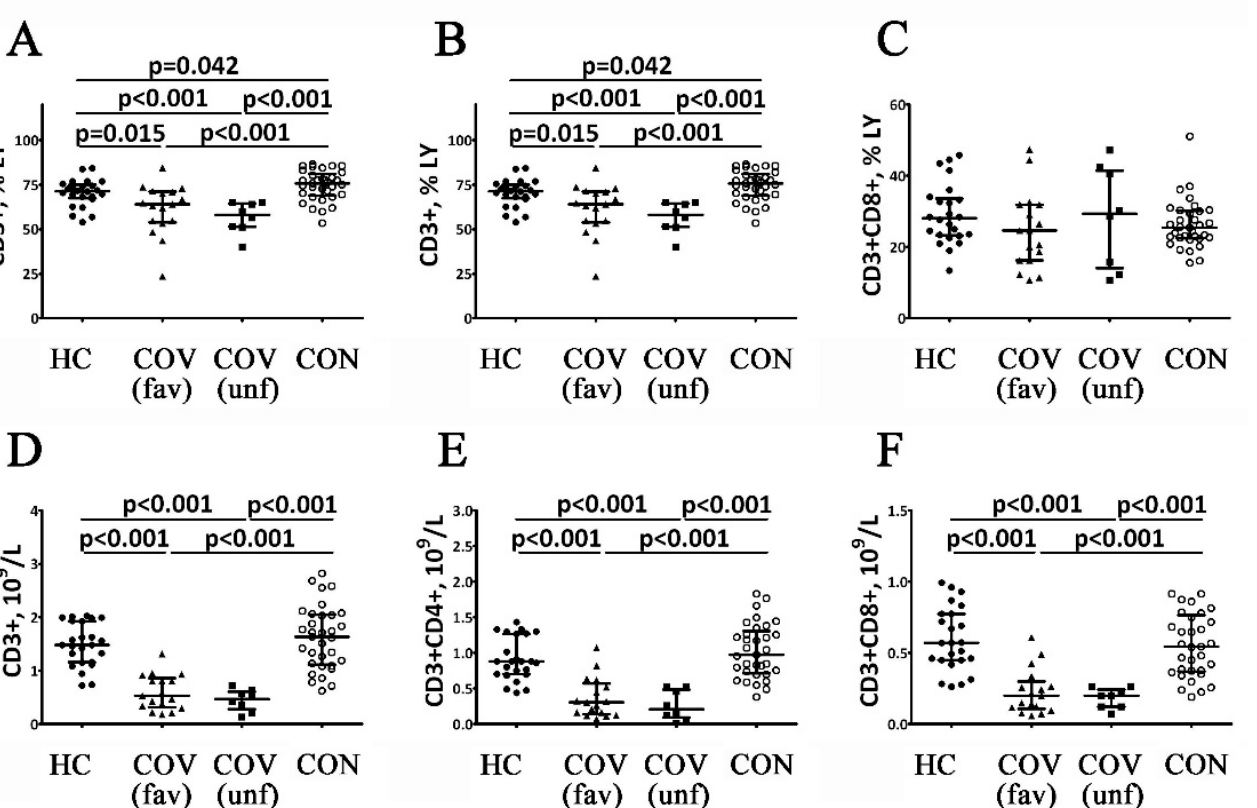
Figure 2. Altered relative and absolute numbers of main T cell subsets in patients with acute COVID- 19 and COVID-19 convalescent patients. Scatters plots ( A – C ) and ( D – F ) showing the percentages (the percentage of T cell subset within total lymphocyte population) and absolute numbers (number of cells in 1 liter of peripheral blood, 10 9 /L) of T cells (CD3 + ), T-helpers (CD3 + CD4 + ) and cytotoxic T cells (CD3 + CD8 + ), respectively. Black circles—healthy control (HC, n = 24); black triangles—patients with acute COVID-19 (COV (fav), favorable outcome, n = 25); black squares—patients with acute COVID-19 (COV (unf), unfavorable outcome, n = 8); and white circles—COVID-19 survivors (CON, convalescent patients with favorable outcome of acute COVID-19, n = 33). Each dot represents individual subjects, and horizontal bars depict the group medians and quartile ranges (Med (Q25; Q75). Statistical analysis was performed with the Mann–Whitney U test.